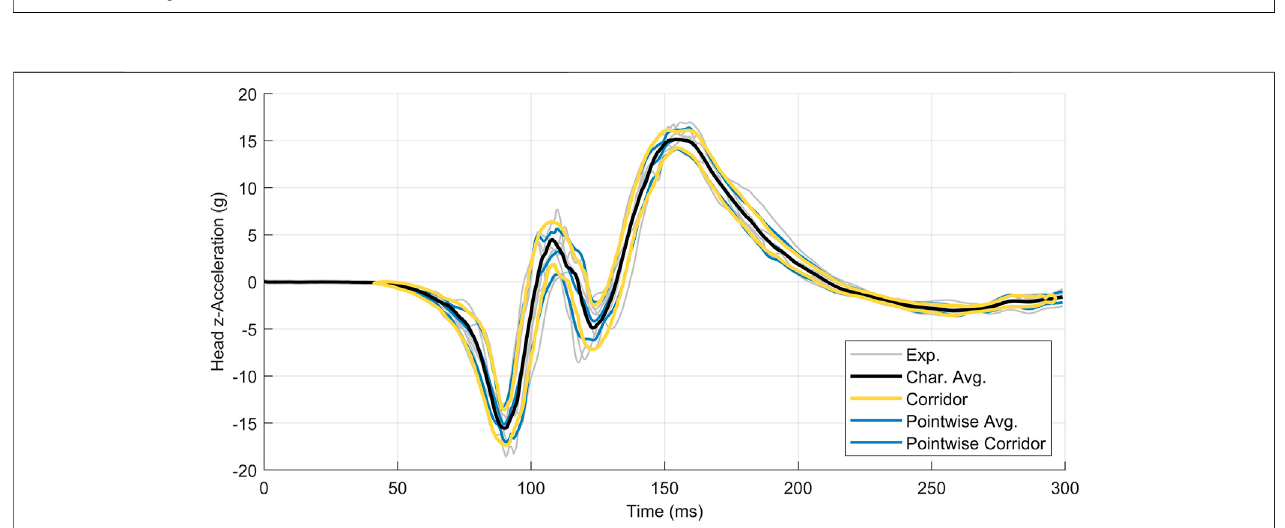
FIGURE 10 | Head z-acceleration for seven subjects, with the characteristic average curve (black) compared to the point-wise average (blue). Corridors are ± 1 standard deviation, m (cid:2) 4 control points, λ (cid:2) 10 − 2 .